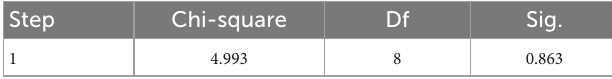
TABLE 5 Hosmer and Lemeshow goodness of fit test